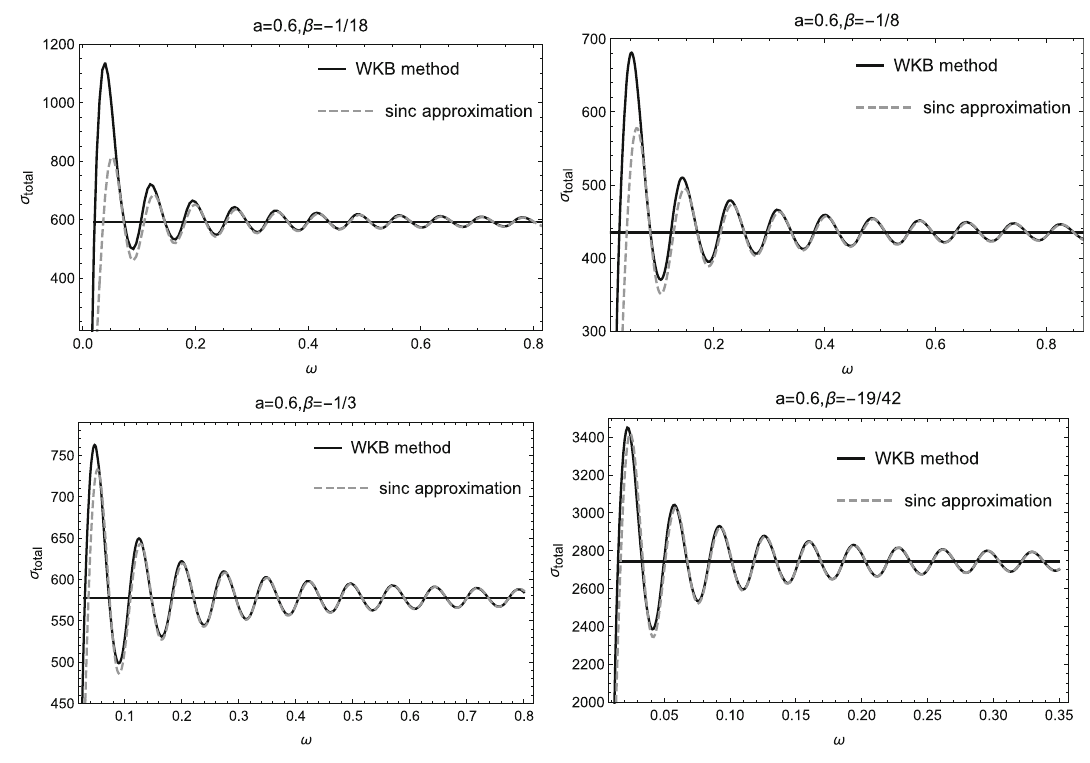
Fig. 7 For β < 0 and M = 1, the total absorption cross section for the variable β with fixed string parameter a = 0 . 6